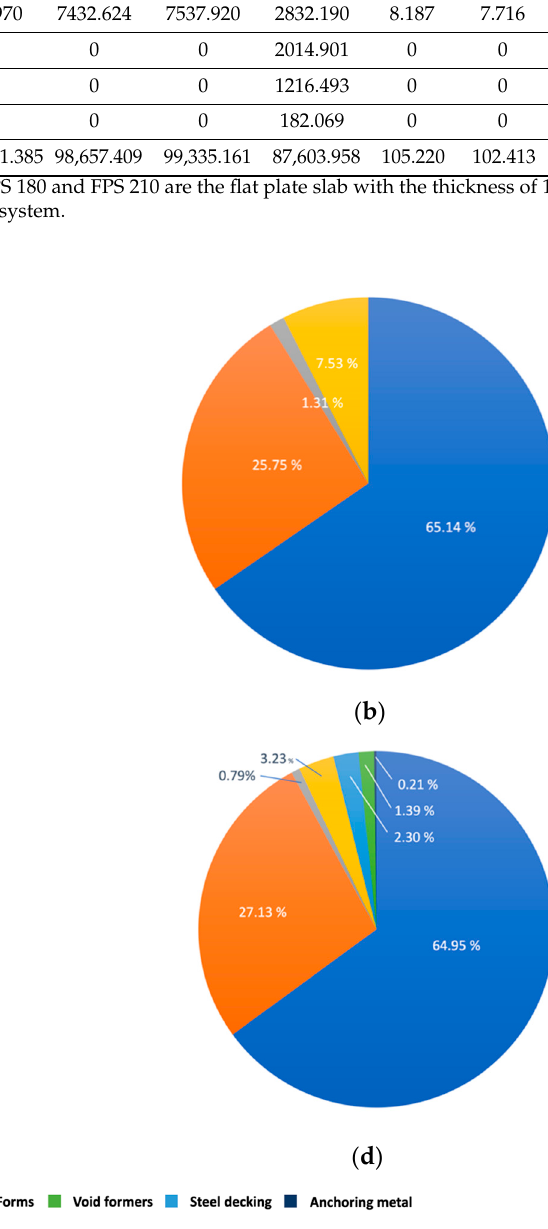
Figure 3. Construction waste generation by materials: ( a ) Solid slab system, ( b ) Flat plate slab (180 mm), ( c ) Flat plate slab (210 mm), ( d ) The void slab system.